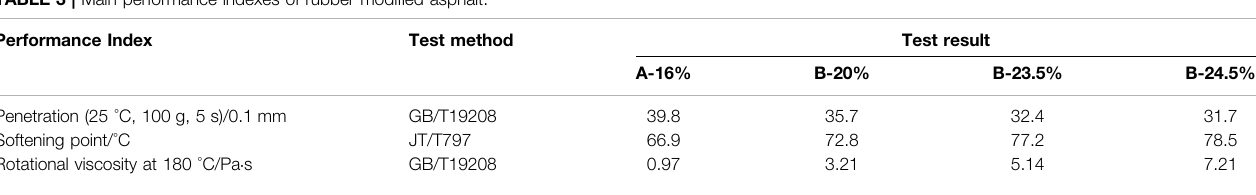
TABLE 3 | Main performance indexes of rubber modi fi ed asphalt.